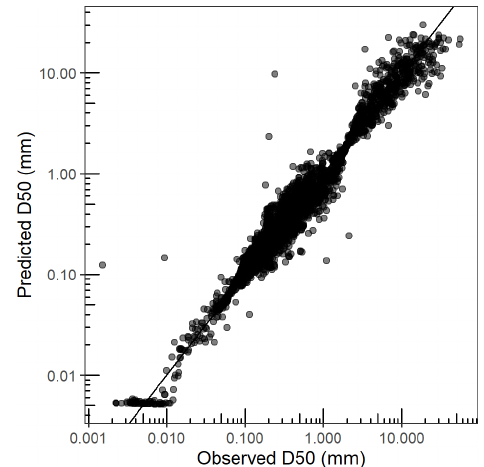
Figure 9. Leave-one-out cross-validation results showing predicted and measured values of median grain size for a dataset compris- ing samples collected from cruises in the Firth of Clyde in April and October 2017 and supplemented with data from the North Sea, Celtic Sea, and English Channel collected by CEFAS and MSS ( n = 3244). Note log 10 scale.